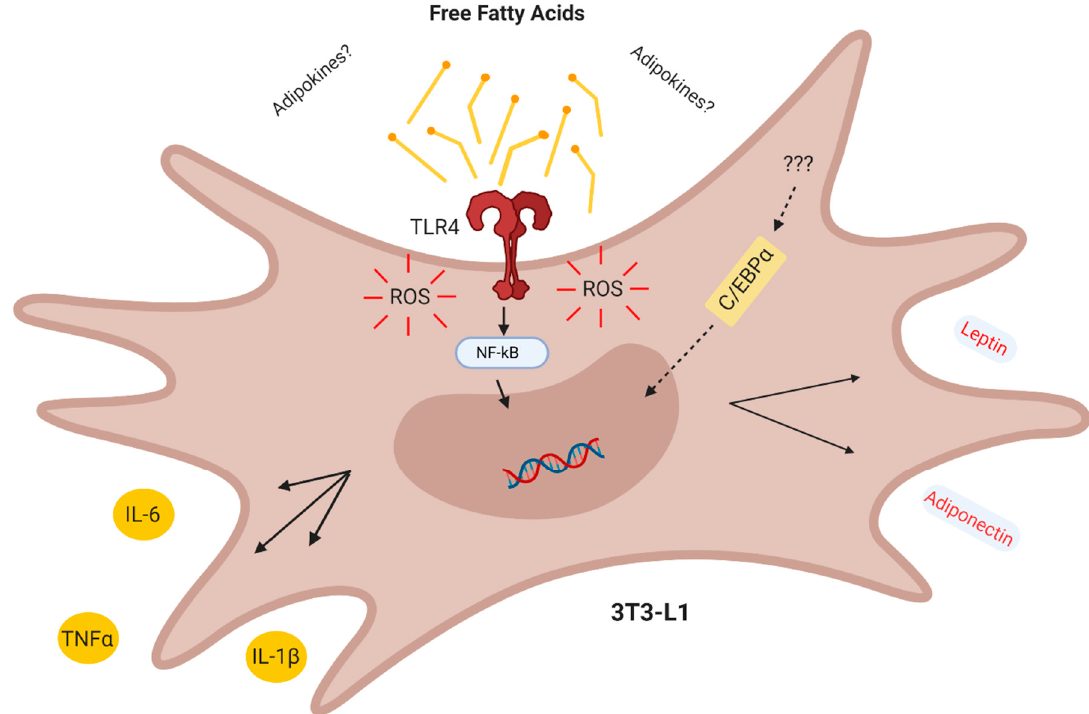
Figure 6. Conclusion. The obese adipose tissue secretes lipokines which act in a combined paracrine/autocrine manner inducing inflammation in preadipocytes via TLR4 and increased ROS, thus creating a paracrine loop which facilitates the differentiation of adipocytes with a proinflammatory profile. Supplementary Materials: The following are available online at http: // www.mdpi.com / 2072-6643 / 12 / 9 / 2828 / s1, Figure S1: 3T3-L1 cells were treated or not with Lean Conditioned Medium (CM), Obese CM, LPS 1 µ g / mL or DMEM 10% FBS at 37 ◦ C / 5% CO 2 . Figure S2: 3T3-L1 cells were left untreated or were pre-incubated with A. Polymyxin or B. Trollox 100 µ M at 37 ◦ C / 5% CO 2 . Figure S3: 3T3-L1 cells were treated or not with Lean Conditioned Medium (CM), Obese CM or LPS 1 µ g / mL for 24 h at 37 ◦ C / 5% CO 2 . Table S1: Composition of the